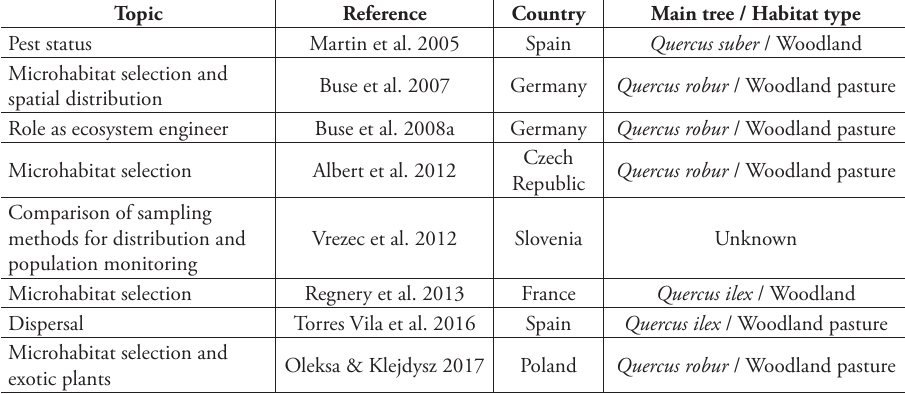
Table 2. Main studies on biology, conservation, and management of Cerambyx cerdo in